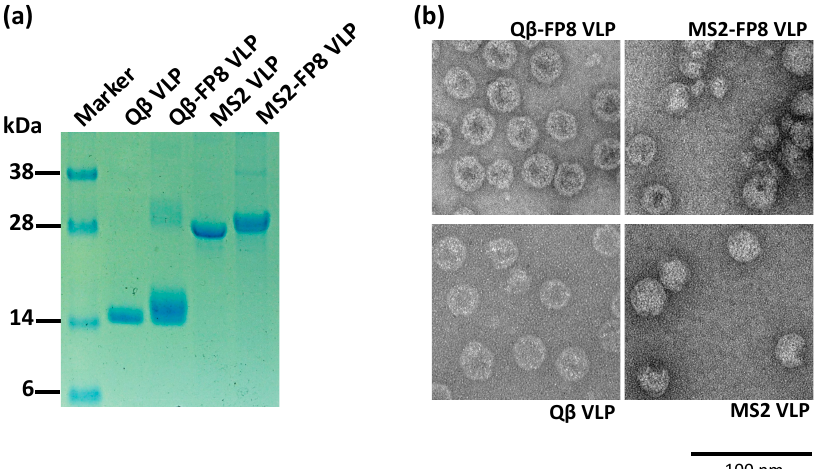
Figure 2. Characterization of conjugated (Q β -FP8) and recombinant (MS2-FP8) VLPs. ( a ) SDS-PAGE analysis of proteins following the conjugation of FP8 peptides to microbially synthesized Q β bacteriophage VLPs and the downstream processing of an E. coli expressed and in vivo assembled MS2-FP8 VLPs. The dominant bands on the gel correspond to product of the expected size. The ladder of bands in the Qß-FP8 VLP lane reflect individual copies of coat protein modified with 0, 1, 2, or more copies of the FP8 peptide. An unmodified version of this gel is shown in Figure S1. ( b ) Transmission electron micrograms (TEM) of conjugated (Q β -FP8) and recombinant (MS2-FP8) VLPs in comparison to unconjugated and unmodified microbially synthesized Q β and MS2 VLPs, respectively. Scale bar is 100 nm.